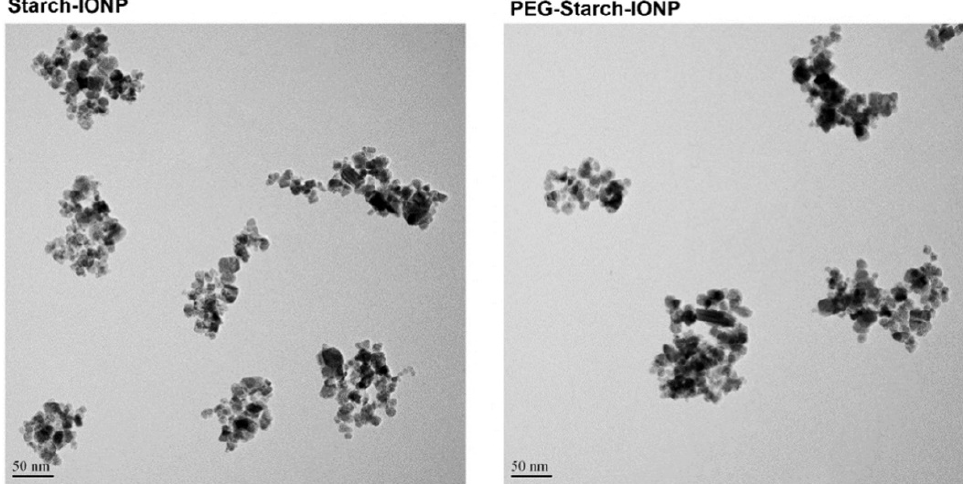
Figure 1. Transmission electron microscopic (TEM) images of starch–IONPs and PEG–starch–IONPs. Scale bar of 50 nm is displayed. (Starch–IONPs: starch-coated iron oxide nanoparticles, and PEG–starch–IONPs: PEGylated starch-coated iron oxide nanoparticles).